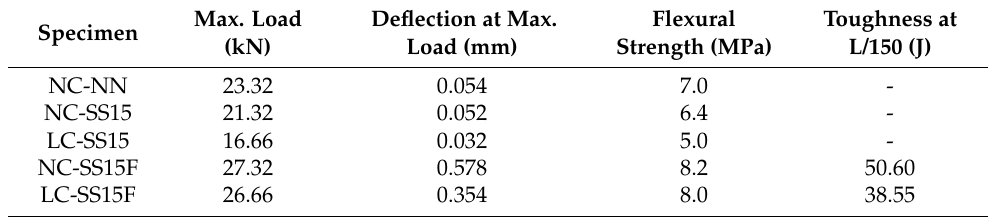
Table 4. Four-point flexural test results.